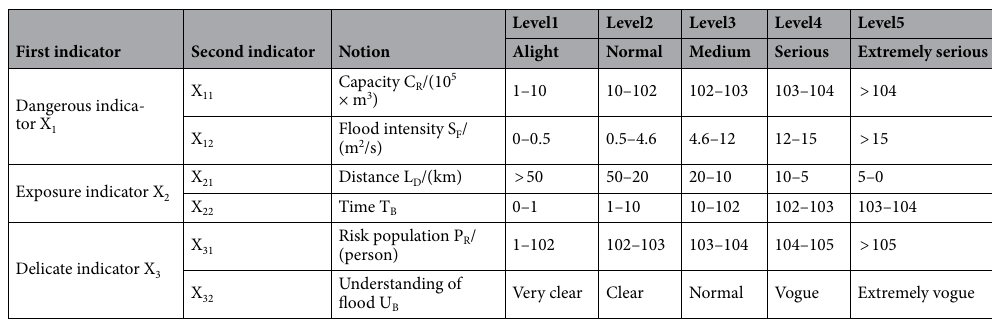
Table 1. Risk index and evaluation standard of life loss in dam break